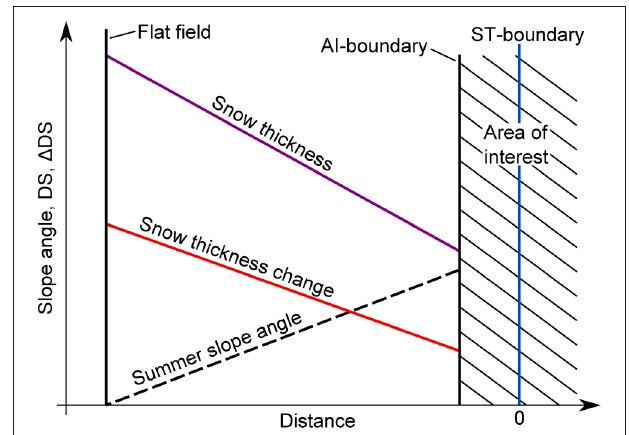
FIGURE A1 | Estimation of the cumulative distribution of the normalized snow volume in an area encompassing all slope angles. A linear change of the variables is assumed between the AI-boundary in the slope toe and the virtual flat field conditions a certain distance away. The x-axis is the same as in Figures 9 , 11